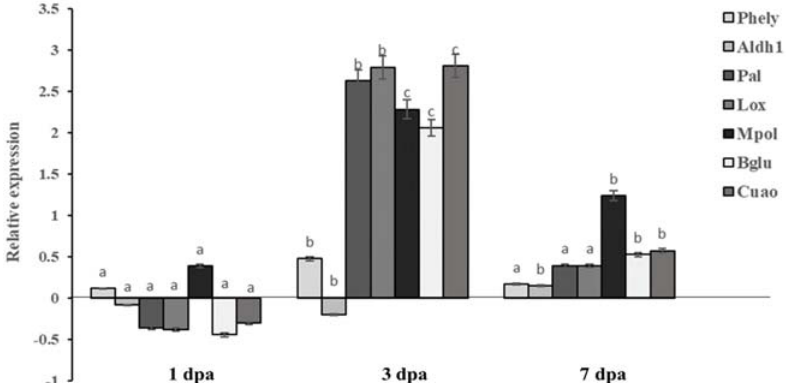
Figure 3. Expression analysis of Olea europaea defense-associated genes by real-time quantitative PCR (RT-qPCR) at three different time-points after application of laminarin (1 dpa, 3 dpa and 7 dpa). The y-axis represents fold differences in gene expression compared to that of plants before laminarin application (time point 0 h). Actin gene was used as endogenous control. Each value is the mean of three biological and three technical replicates ± standard error. Different letters on the columns indicate significant differences inside each gene studied for the three time-points according to analysis of variance (ANOVA) at p = 0.05.